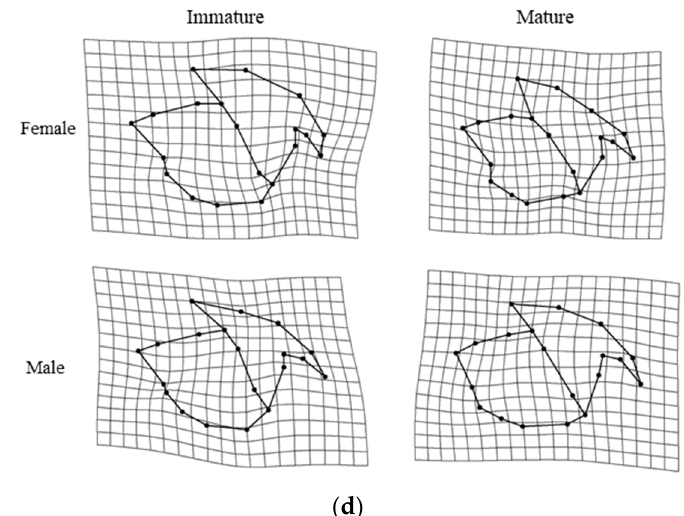
Figure 4. Thin-plate spline deformation grids of upper beak of the four cephalopods considered in different ontogenetic stages. ( a ) Octopus minor . ( b ) Uroteuthis edulis . ( c ) Sepia esculenta . ( d ) Sthenoteuthis oualaniensis .